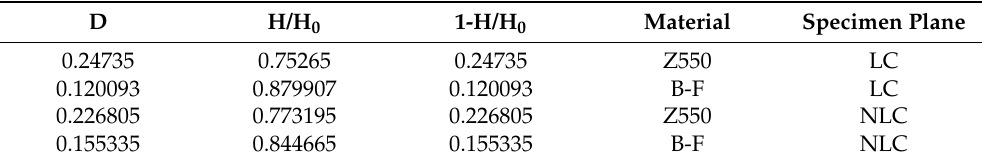
Table 4. Changes in the D parameter of the test materials after thermocycling. LC—light-cured surface of sample (the top side of a sample), NLC—non-light-cured surface (the bottom side of a sample), HK—Knoop